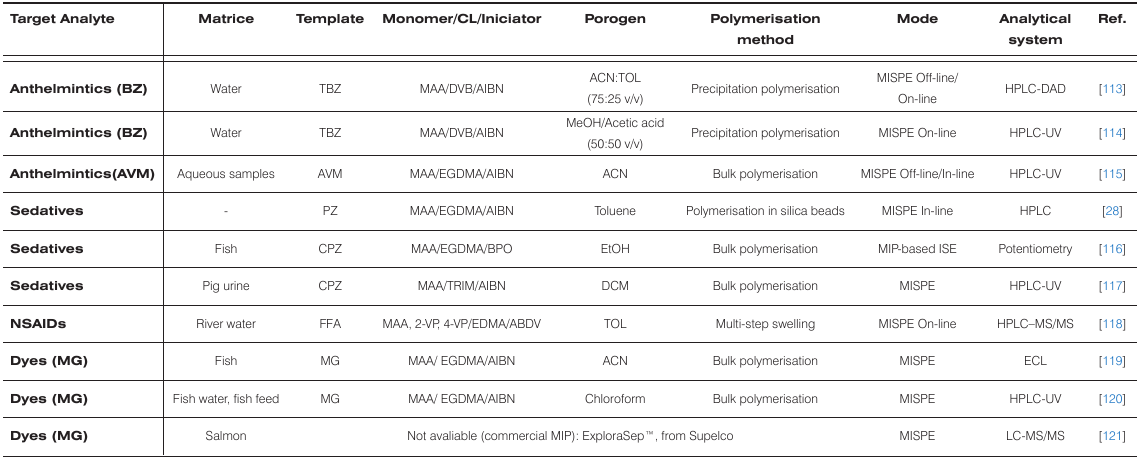
Table 3. Application of molecularly imprinted technology to the analysis of group B2 and B3 substances (Council Directive 96/23/EC) in